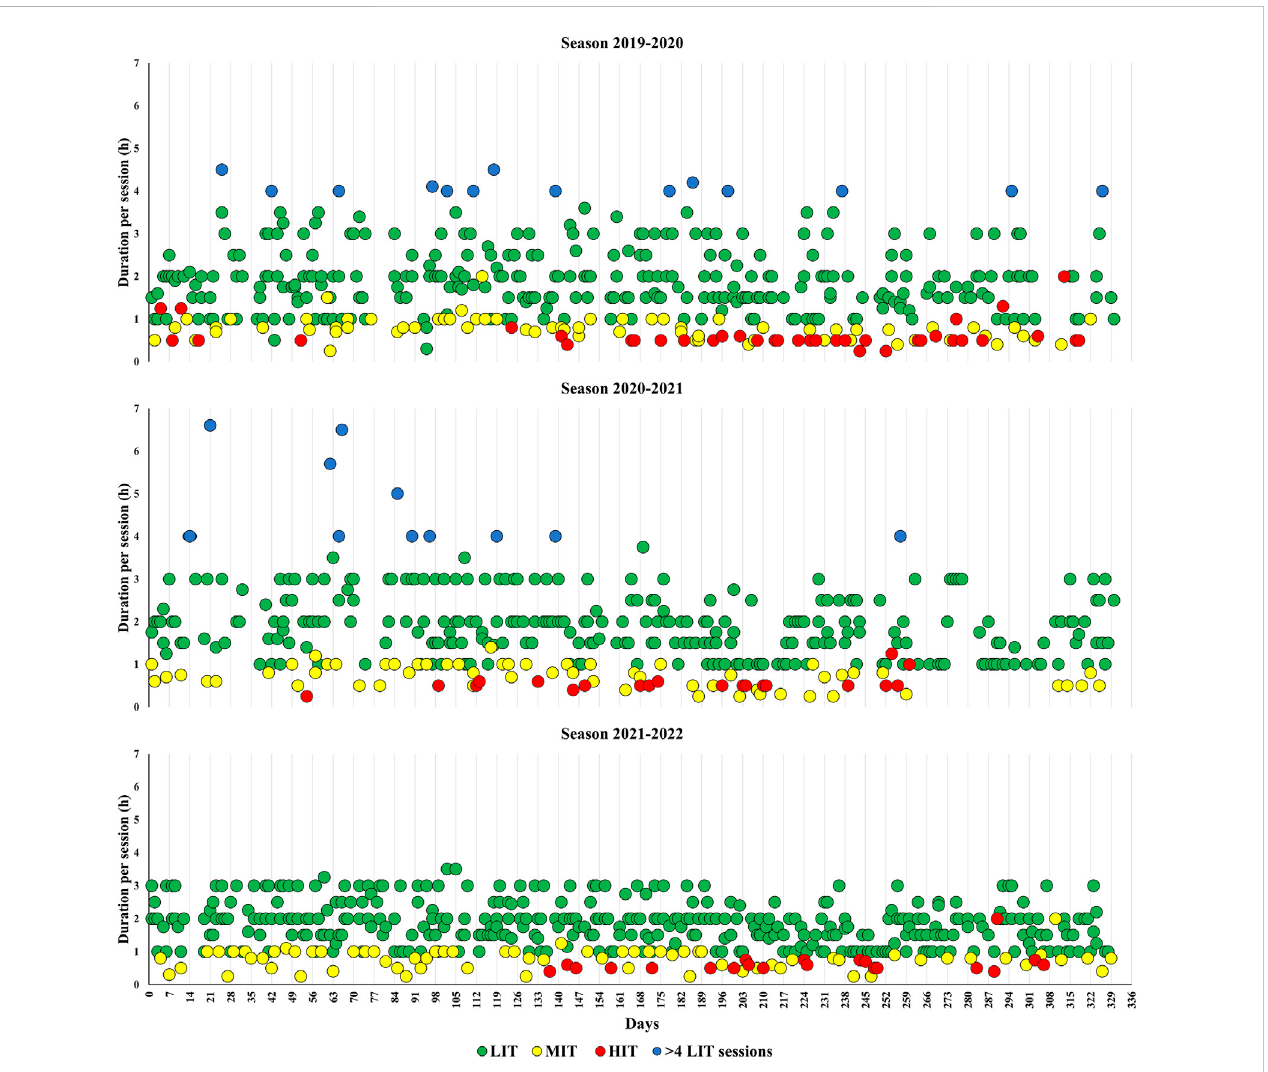
FIGURE 3 The duration of low- (LIT), moderate- (MIT) and high-intensity training (HIT) sessions over two seasons of unexpected underperformance (2019- 2020 and 2020-2021) and the season returning to world-class level in a male cross-country skier. *LIT in connection with warm-up and cool-down are not included.